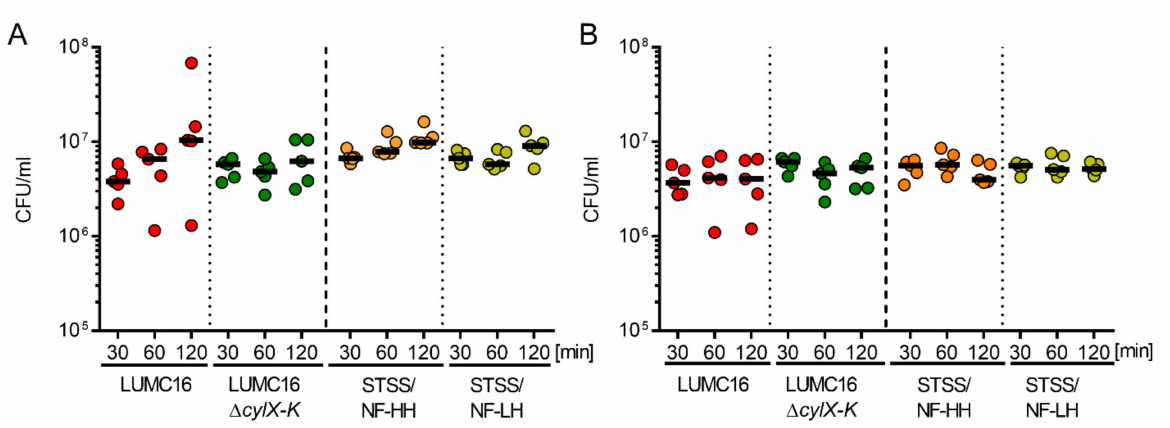
Figure 5. Human platelets do not kill GBS. CFU of the indicated GBS strains after 30, 60, and 120 min of platelet infection ( A ) or incubation with platelet releasate ( B ). Each dot represents one independent experiment with washed platelets from one donor ( n = 5). Horizontal lines depict mean values. Abbreviations (CFU, colony-forming